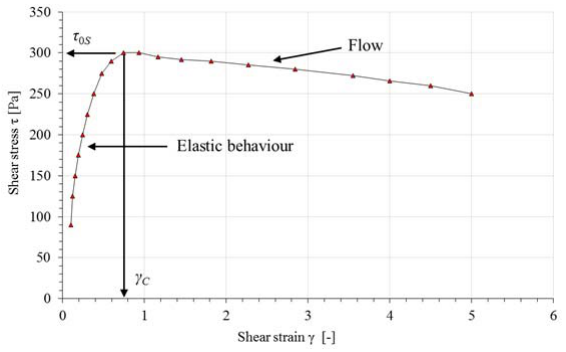
Figure 4 . Determination of static yield stress τ 0S in a shear strain test.